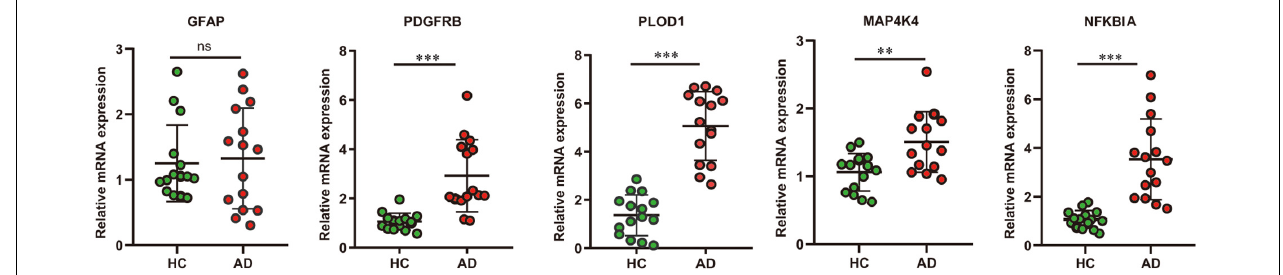
FIGURE 9 | The result of quantitative real-time reverse transcription-polymerase chain reaction (qRT-PCR) illustrated the mRNA expression levels of GFAP, PDGFRB, PLOD1, MAP4K4, NFKBIA in patients with AD ( n = 15) and healthy controls ( n = 15). Significance level was denoted by ∗∗ p -value < 0.01, ∗∗∗ p -value <